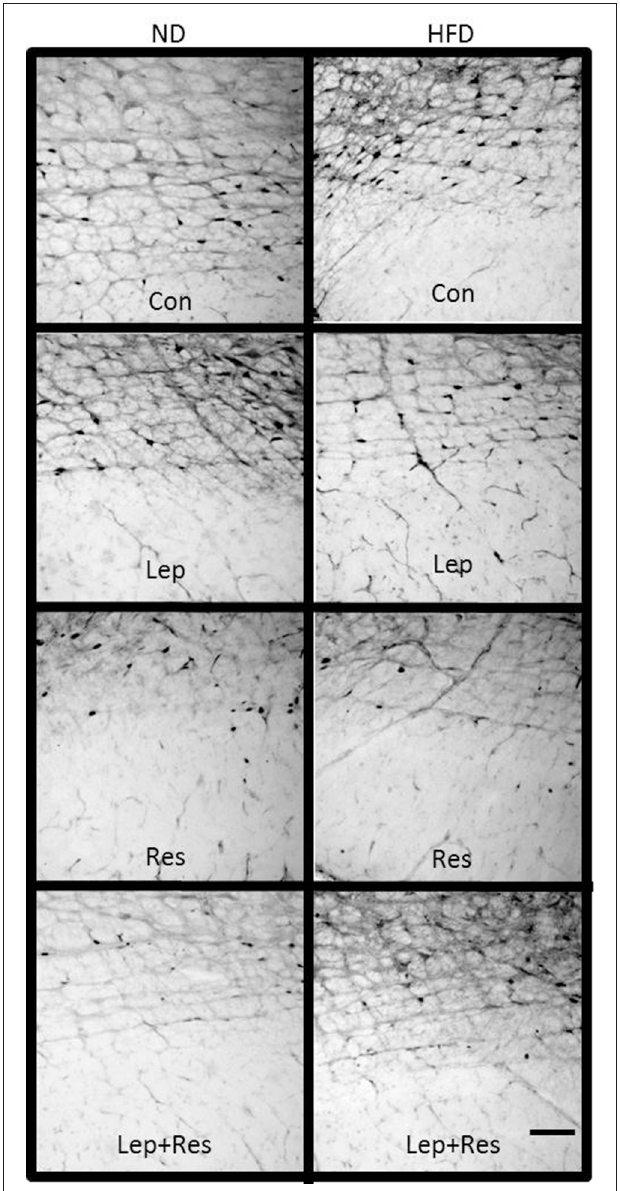
FIGURE 15 | Photomicrographs showing Fos-positive cell nuclei in the rostral ventromedial medulla of rats fed a high fat diet (HFD) and rats fed a normal diet (ND) following centrally administered saline (5 µ l; control) leptin (7 µ g), resistin (7 µ g) or leptin combined with resistin. Scale bar = 100 µ m. The rostrocaudal levels of the sections counted were at ∼ 12.2–12.4mm caudal of bregma.